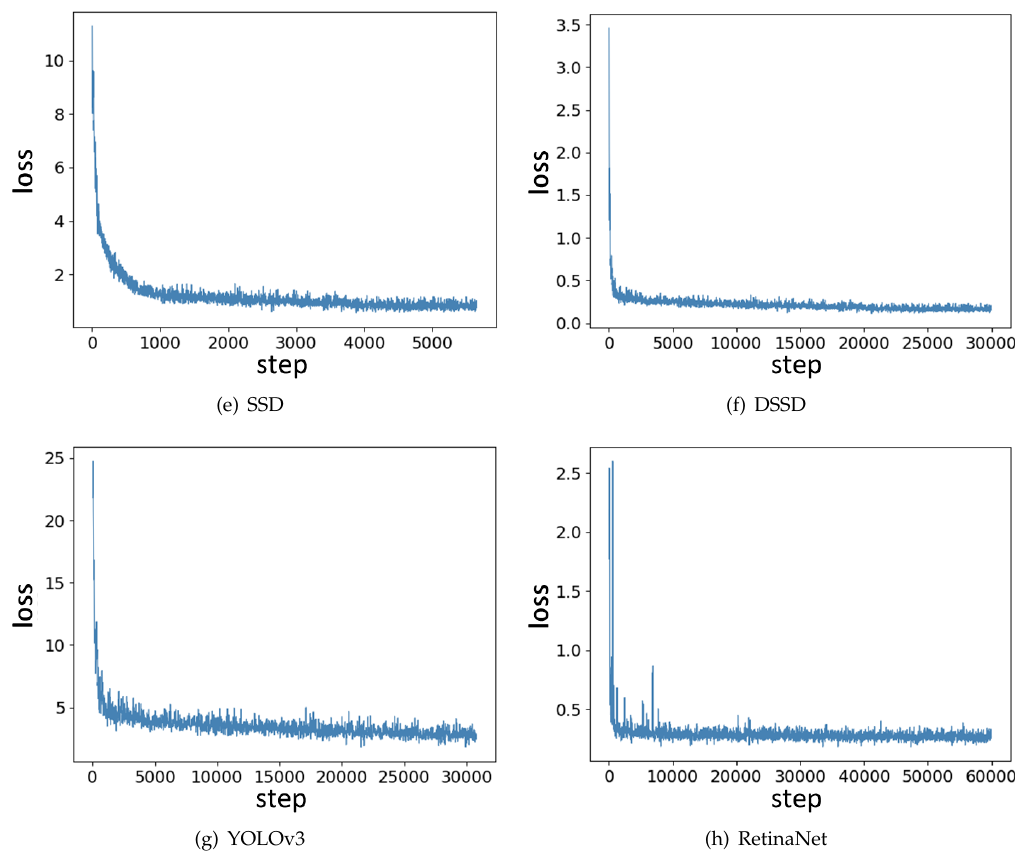
Figure 10. Changes of loss with steps during training.